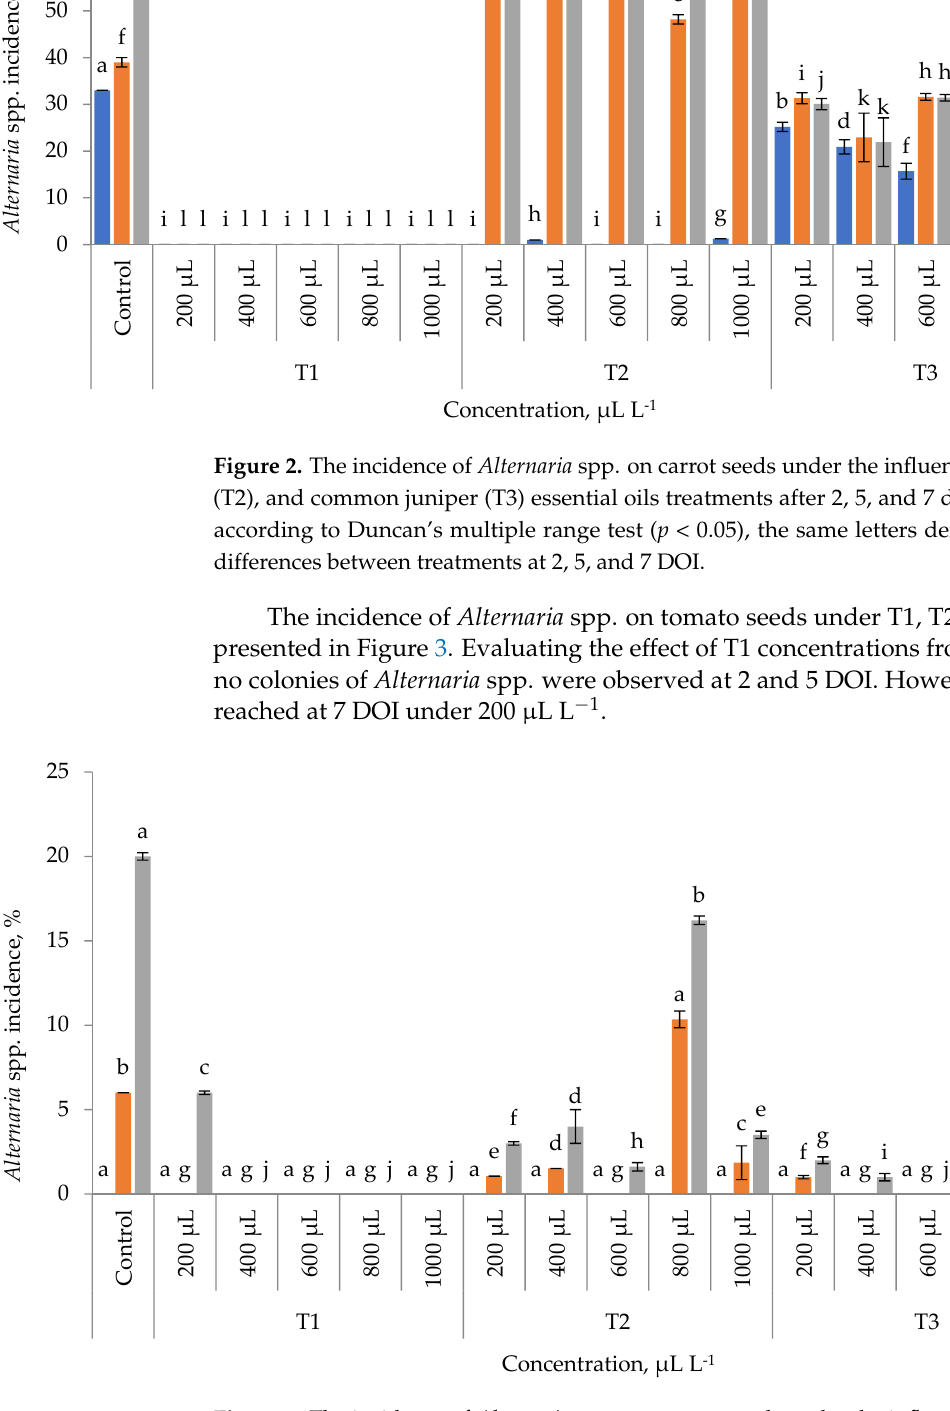
Figure 3. The incidence of Alternaria spp. on tomato seeds under the influence of thyme (T1), hyssop (T2), and common juniper (T3) essential oils treatments after 2, 5, and 7 days of incubation (DOI); according to Duncan’s multiple range test ( p < 0.05), the same letters demonstrate no significant differences between treatments at 2, 5, and 7 DOI.